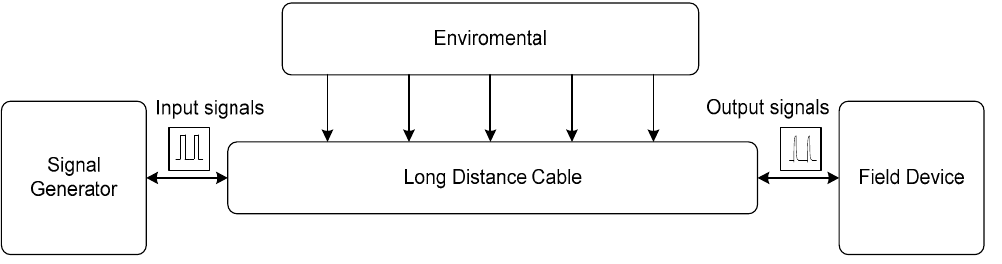
Figure 5. A general diagram of communication via a long ‐ distance cable.